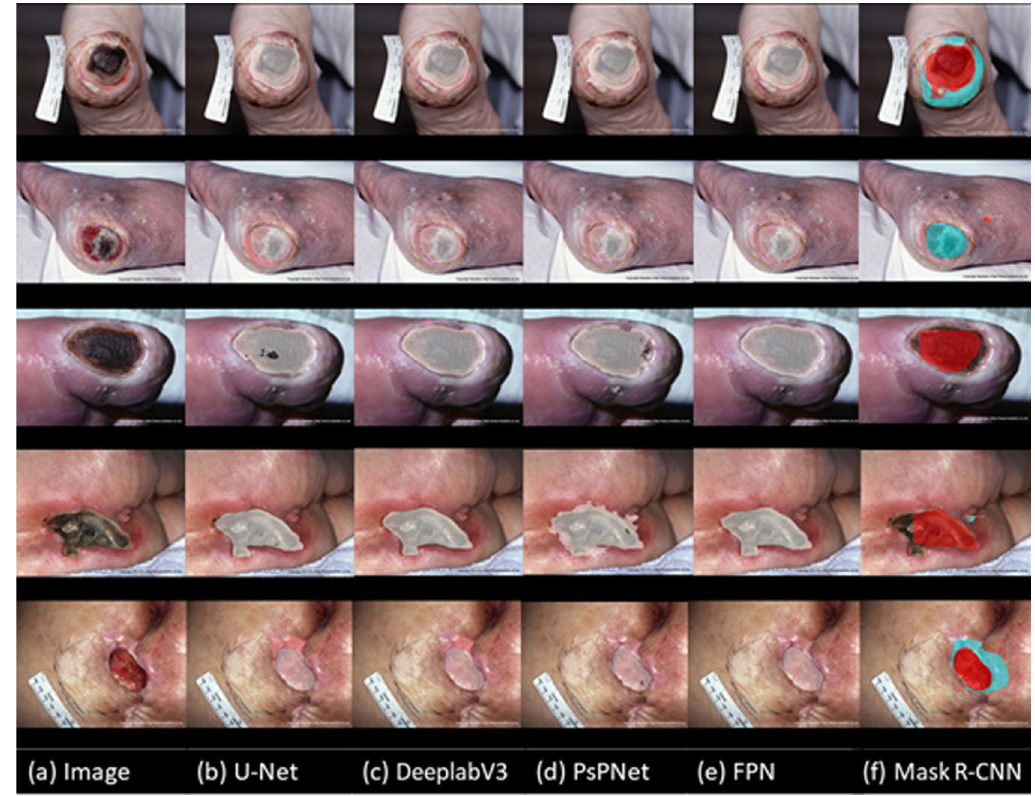
Fig 5. Collage of results of wound segmentation and re-ep detection from the Medetec Wound Database.